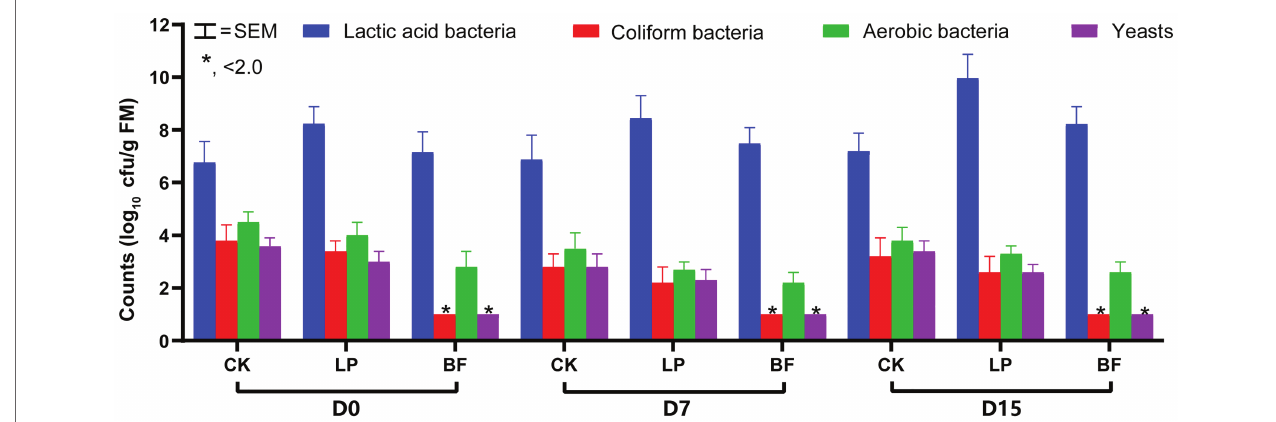
FIGURE 1 | Microbial composition of corn stalk silages treated without (CK) or with L. plantarum and BF. D0, D7, and D15 indicated corn stalks after 0, 7, and 15 days of ear harvest; SEM, standard of error mean; *significance at p <